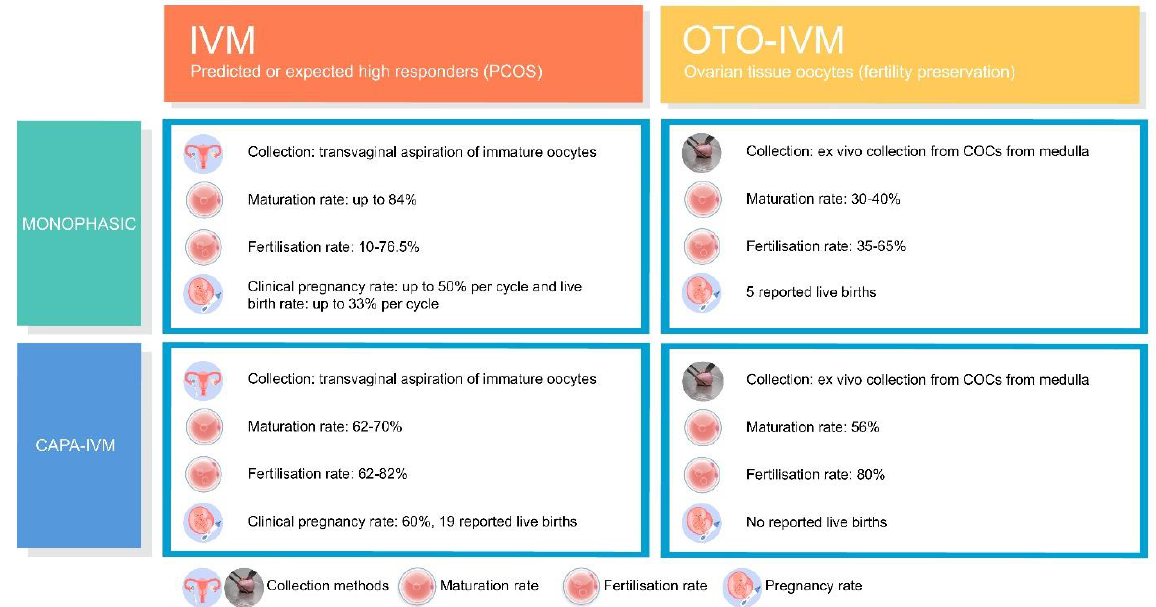
Figure 2. Overview of success ratios achieved with current IVM methods [11,13,27,28,35,38,42 – 44,58,59].